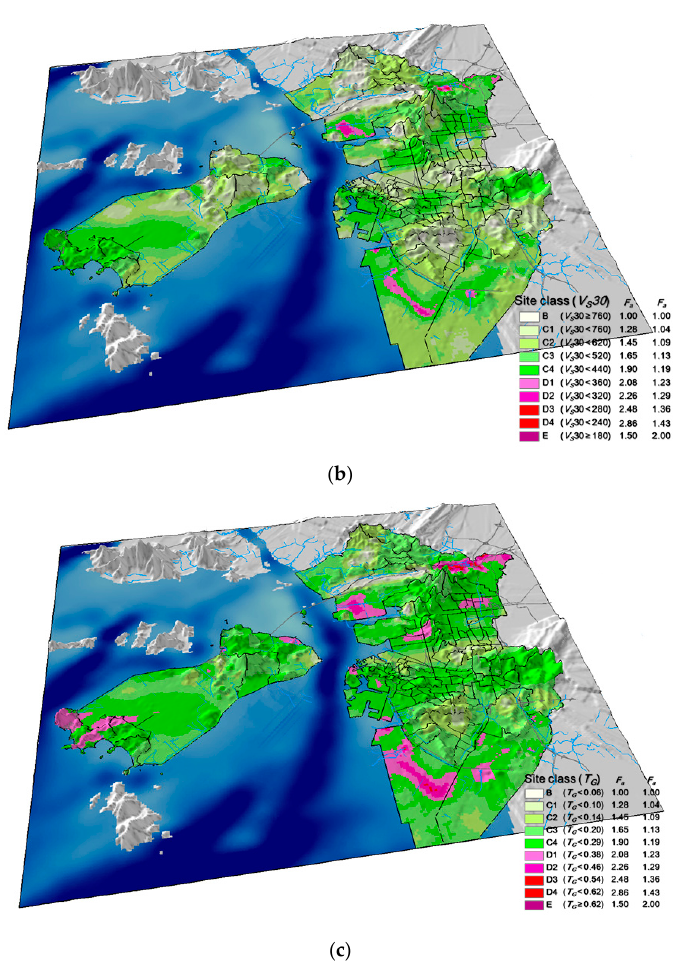
Figure 10. 3D view of spatial distribution of site classes in Incheon based on the proposed site response parameters: ( a ) H ; ( b ) V S 30 ; ( c ) T G .